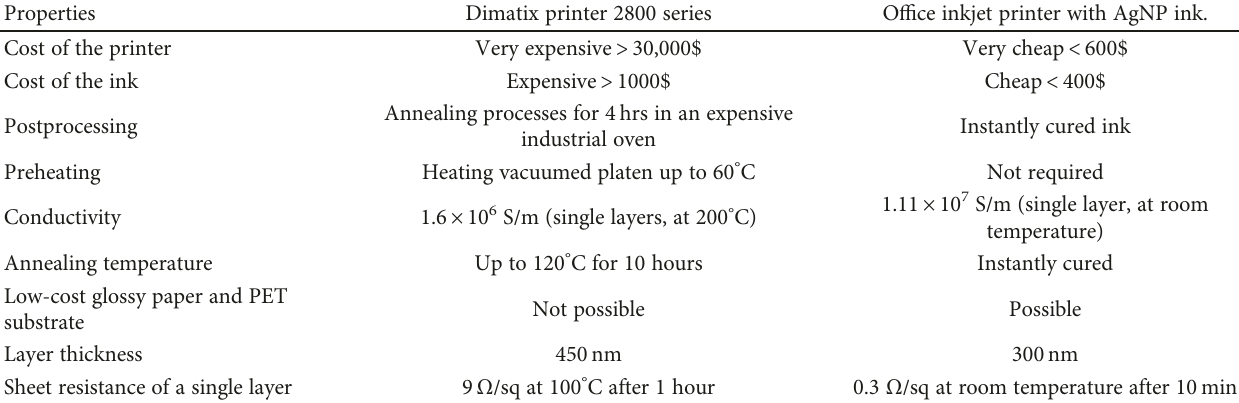
Table 1: Comparison between the o ffi ce inkjet printer and commercially Dimatix 2800